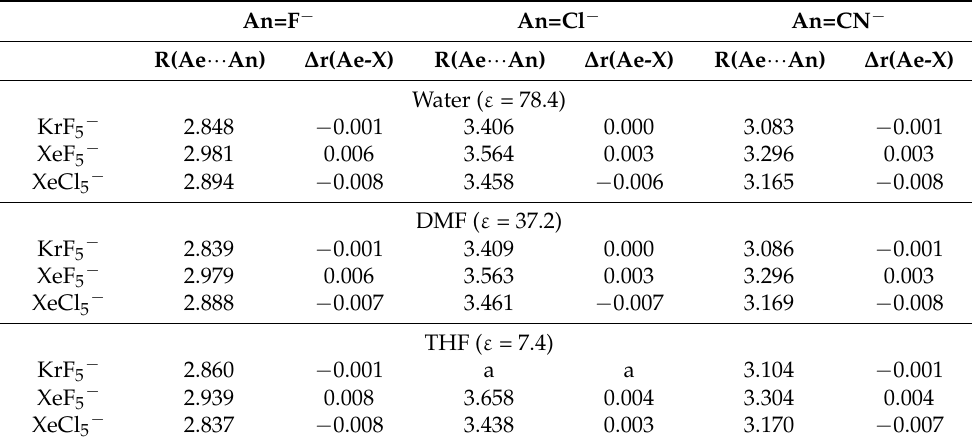
Figure 2. Optimized geometries of sample anion-anion complexes ( a ) KrF 5 − ··· NC − , ( b ) XeCl 5 − ··· Cl − , and ( c ) XeF 5 − ··· F − . Table 2. Intermolecular distances and change in internal bond lengths (Å) upon complex